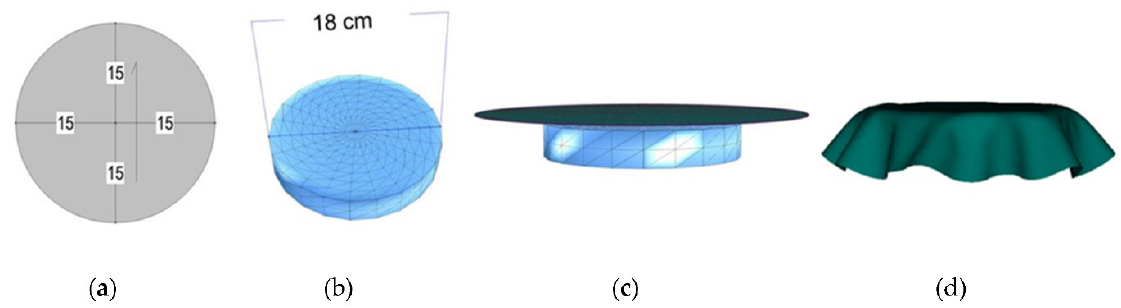
Figure 3. The process of fabric drape computer simulation in the Optitex CAD system: ( a ) creation of a planar circular sample of given dimensions; ( b ) a solid disk model of specified dimensions; ( c ) positioning of the planar circular sample above the disk model; ( d ) computer simulation of fabric drape.